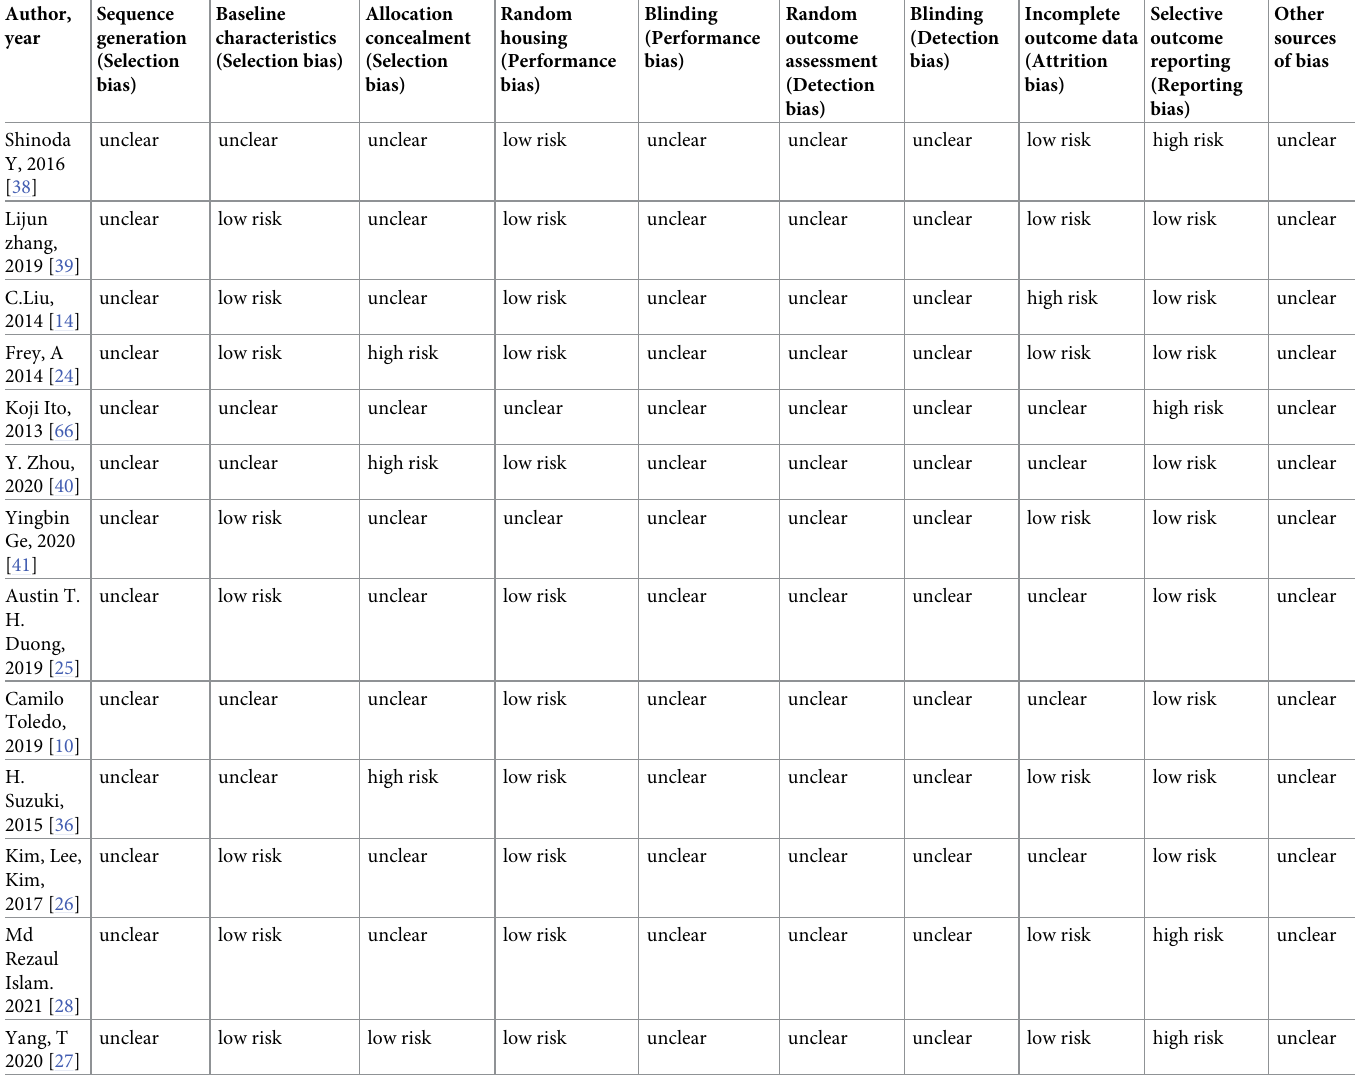
Table 5. SYRCLE’s risk of bias tool of animal